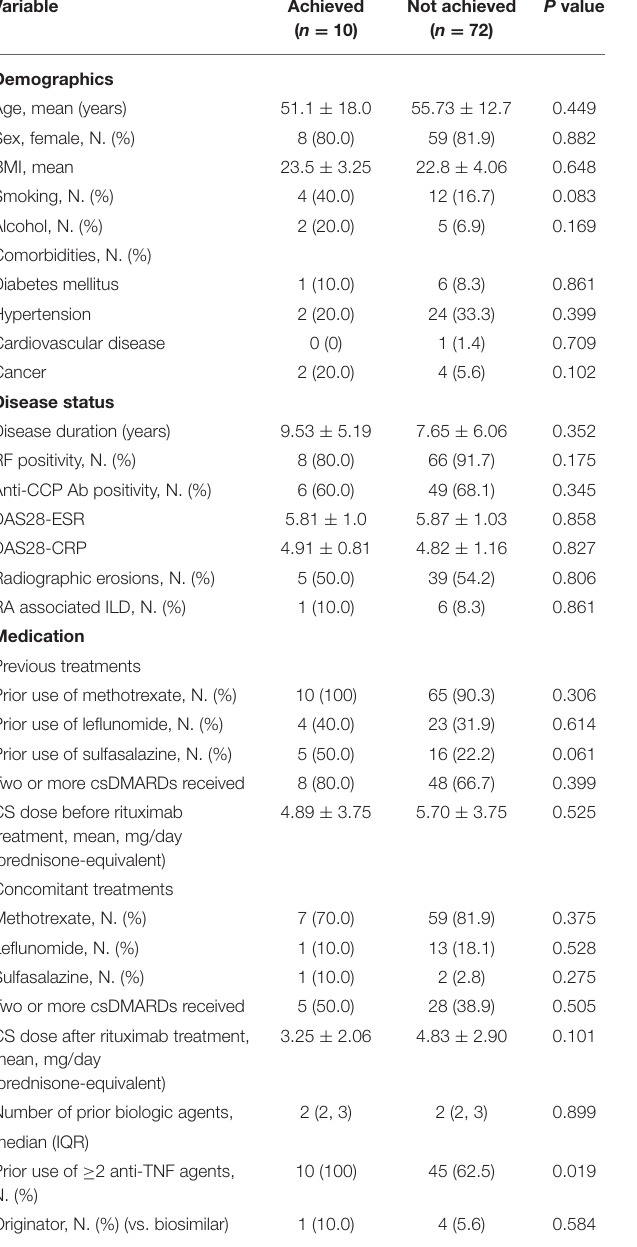
TABLE 3 | Clinical characteristics of patients who achieved and did not achieved biologic-free remission after first cycle. Variable P value